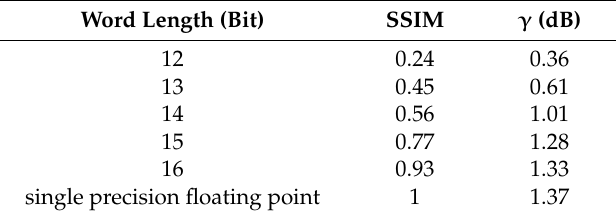
Table 5. Actual scene (local region) imaging quality assessment for different FFT processing accuracies.